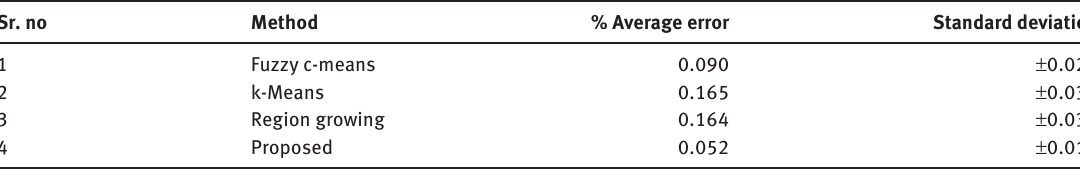
Table 6: Percentage Average Error and Standard Error on 10 Images. Sr. no